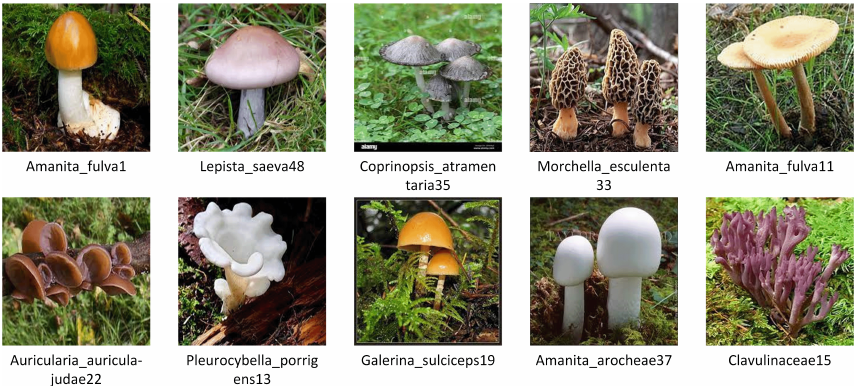
Figure 1. Images of some species of mushrooms included in Mushrooms